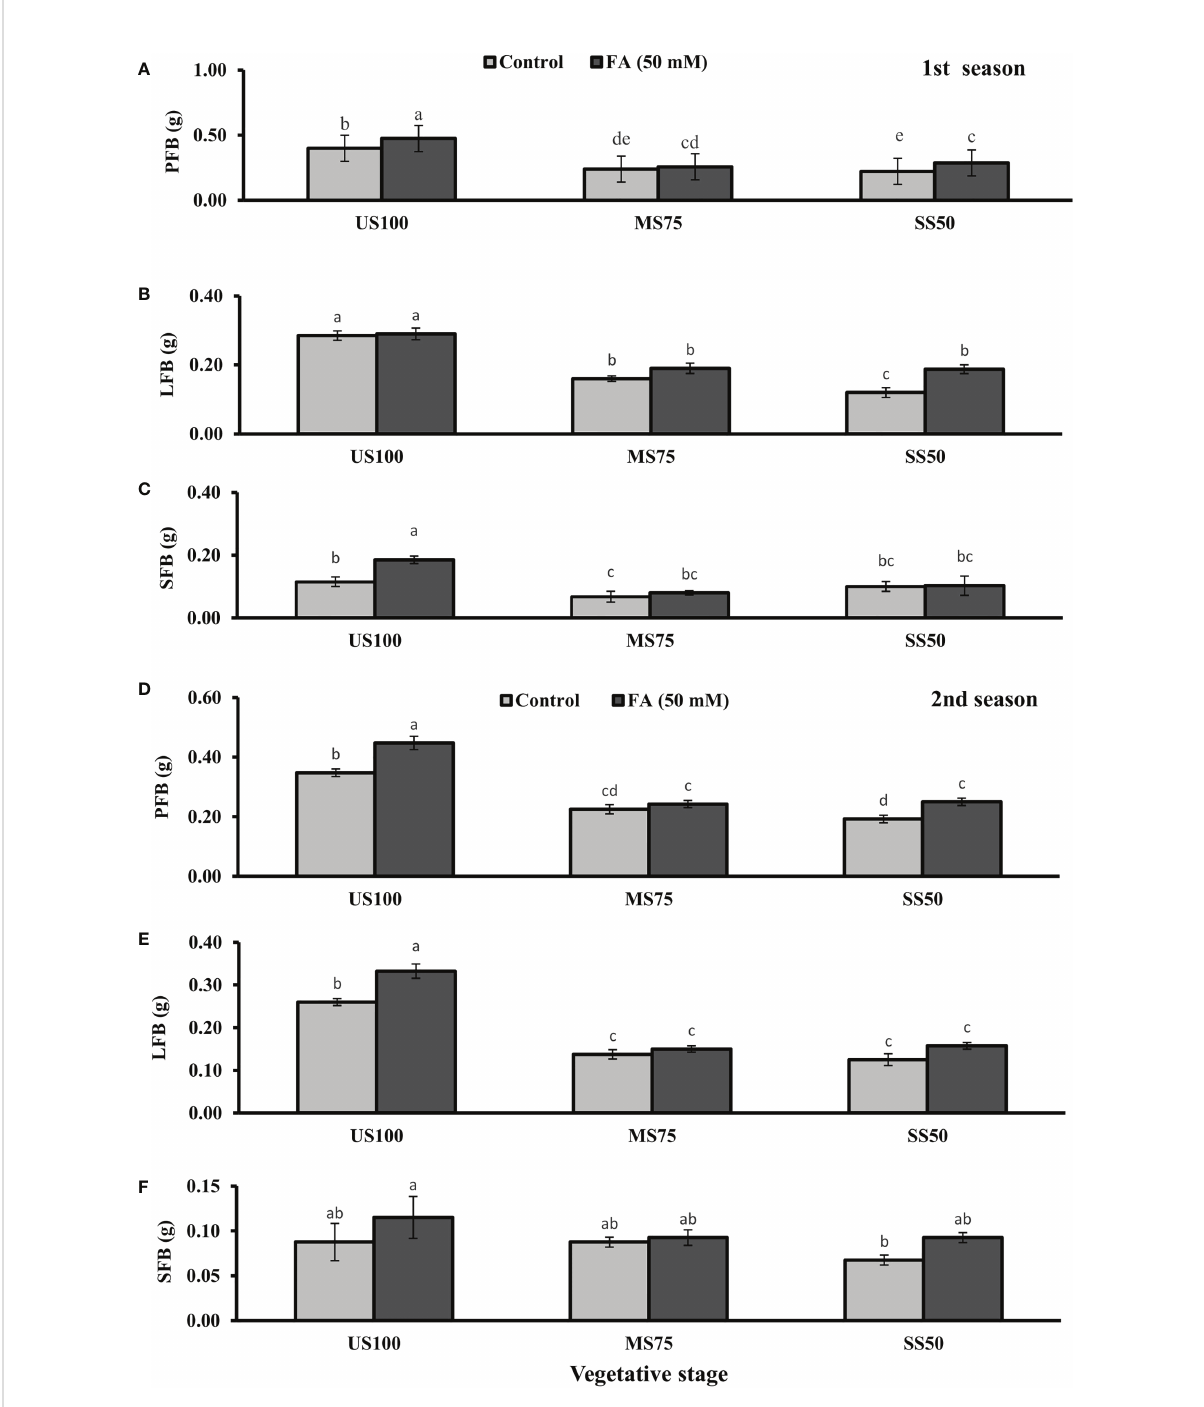
FIGURE 1 Effect of foliar application of folic acid (50 mM) at the vegetative stage on (A, D) plant fresh biomass/plant, (B, E) leaf fresh biomass/plant, and (C, F) shoot fresh biomass in the fi rst and second seasons. The graph values are the mean ± SE of four replicates. The bars exhibited with different letters indicate a signi fi cant difference between samples by least signi fi cant difference ( p ≤